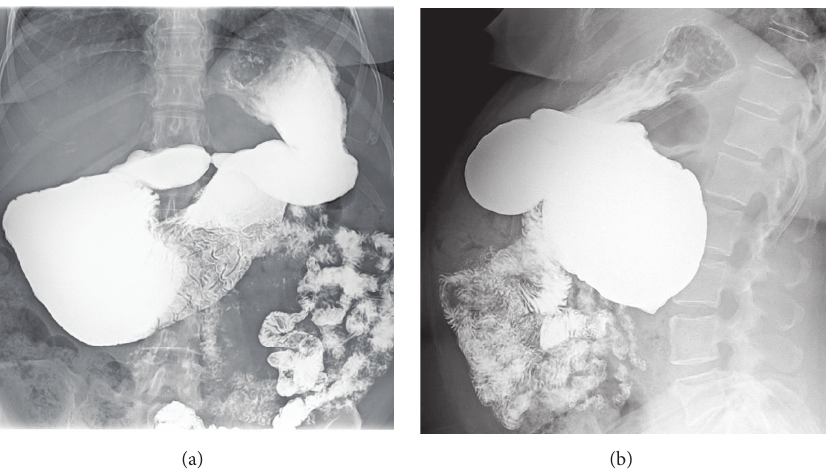
Figure 1: Representative images from the preoperative small bowel follow-through. There appeared to be marked abnormal dilation involving the duodenal C-loop. Of note, there was vigorous peristaltic activity involving this dilated loop although the peristaltic activity was disordered with a “to and from” movement of the barium and a marked delay in emptying into jejunum. The finding of peristaltic activity, although disordered, argued against the possibility of this being a duodenal diverticulum. (a) AP image. (b) Lateral image.